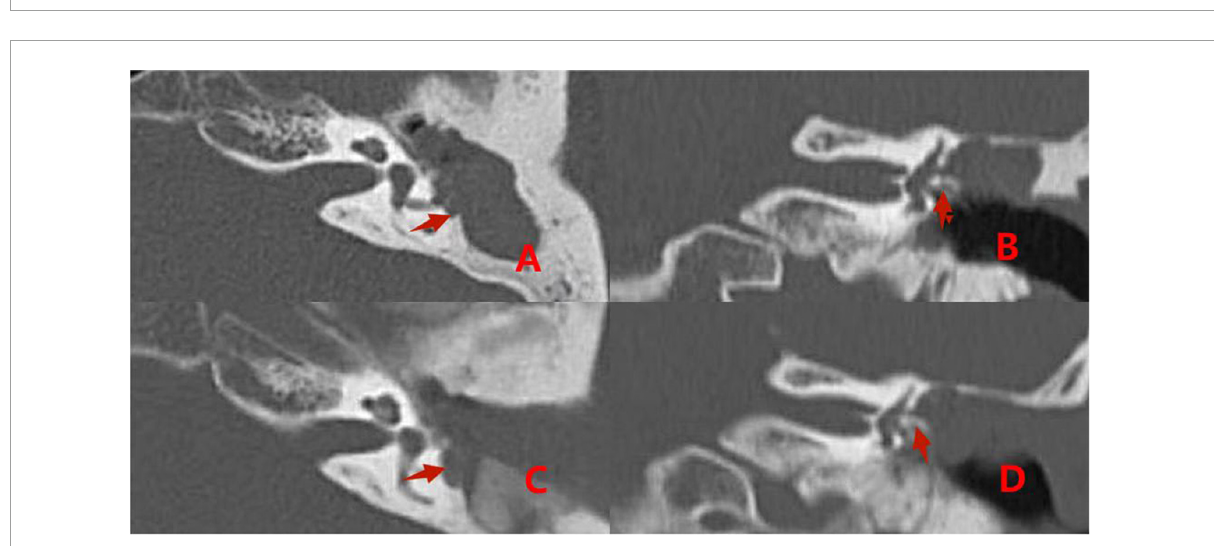
FIGURE7 Pre- and postoperative CT images acquired from a patient with a type III labyrinthine fistula. Preoperative (A,B) : The left cholesteatoma is adjacent to the bone destruction (the red arrows). Postoperative (C,D) : The removal of the cholesteatoma, the abnormal shape of the external semicircular canal, and intraoperative fillers inside and adjacent to it (the red